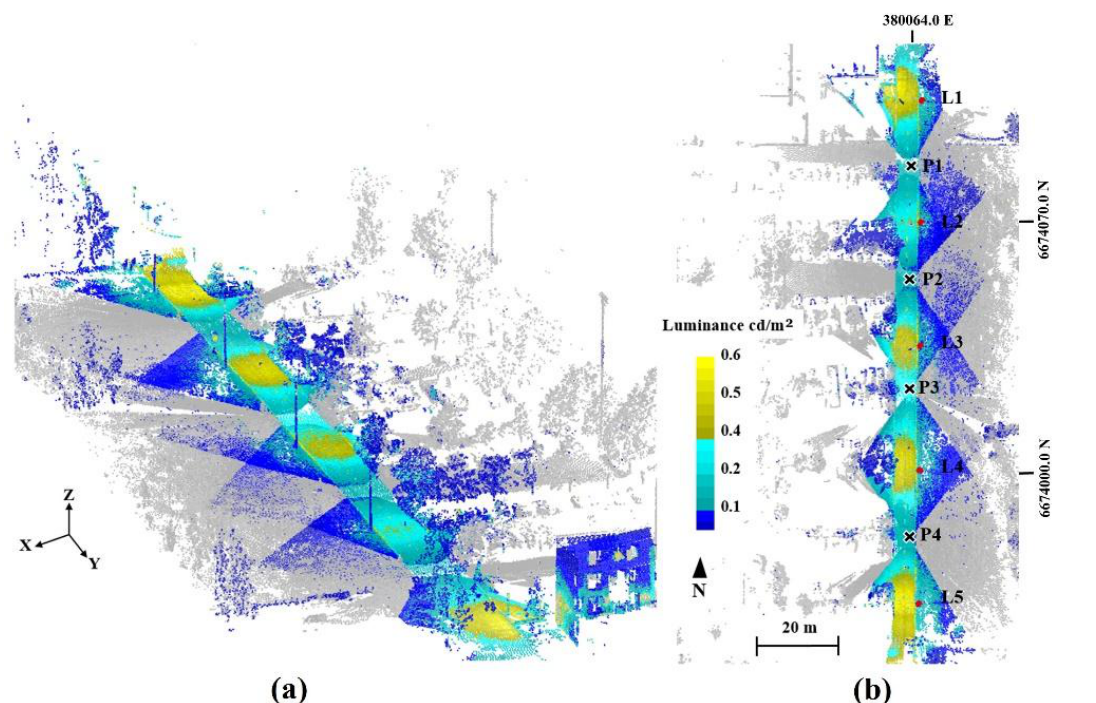
Figure 5. The derived 3D luminance data of the road section; ( a ) bird’s-eye view and ( b ) orthographic view, from above. The points which are not textured by images are shown in grey. The positions of the scan and image stations are marked with black crosses (P1–P4) and lamp posts are marked with red dots (L1–L5). Coordinates are presented in